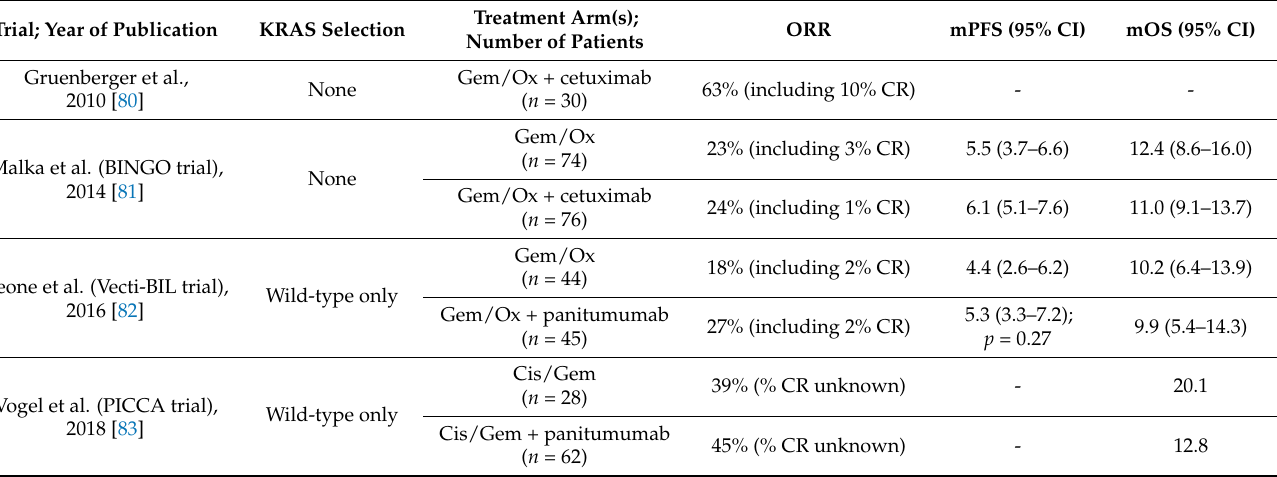
Table 2. Selected trials of monoclonal antibodies against the epidermal growth factor receptor in advanced biliary tract